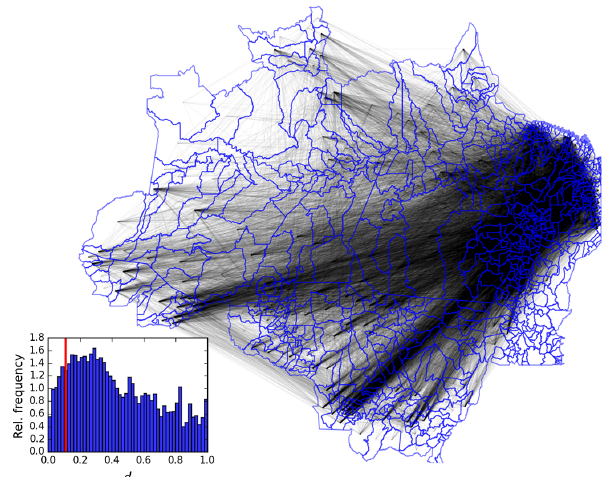
Figure 5. Illustration of a similarity network with a spatial division in municipalities for transitions from clean pasture to other land- cover classes between 2010 and 2012. Inset: histogram of difference metric values with threshold in